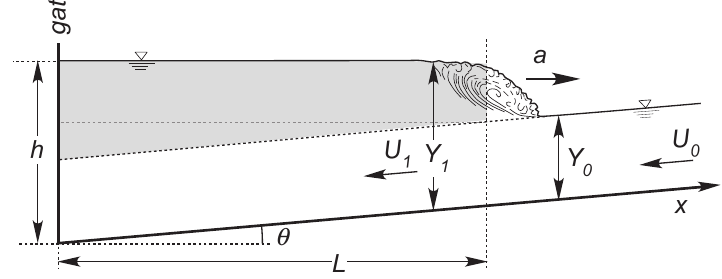
Figure 1. Schematic of the surge propagating upstream against a uniform flow of depth Y 0 and velocity U 0 , with